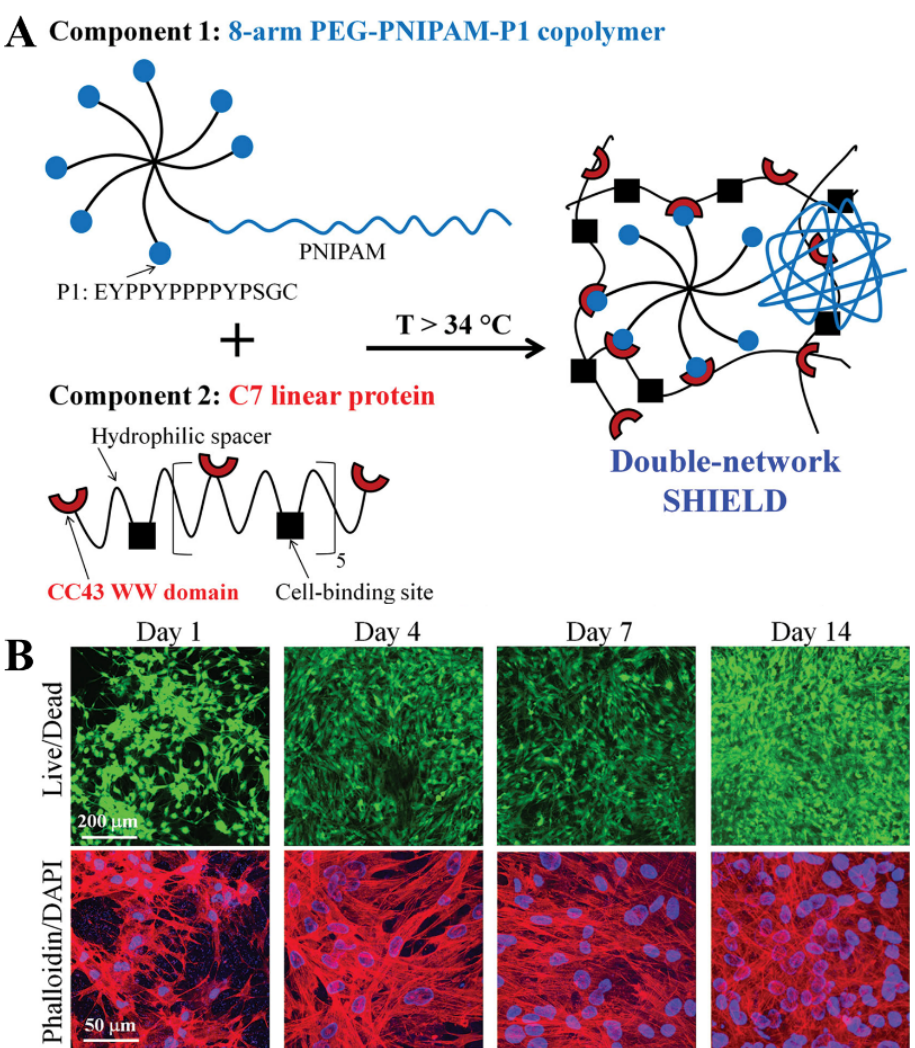
Figure 2. Retention of transplanted stem cells enhanced by thermo-responsive injectable hydrogels with in situ double network formation. ( A ) Structural design of SHIELD. ( B ) Confocal images of hASCs cultured in SHIELD. Reproduced from [61] with permission. Copyright 2015 Wiley.